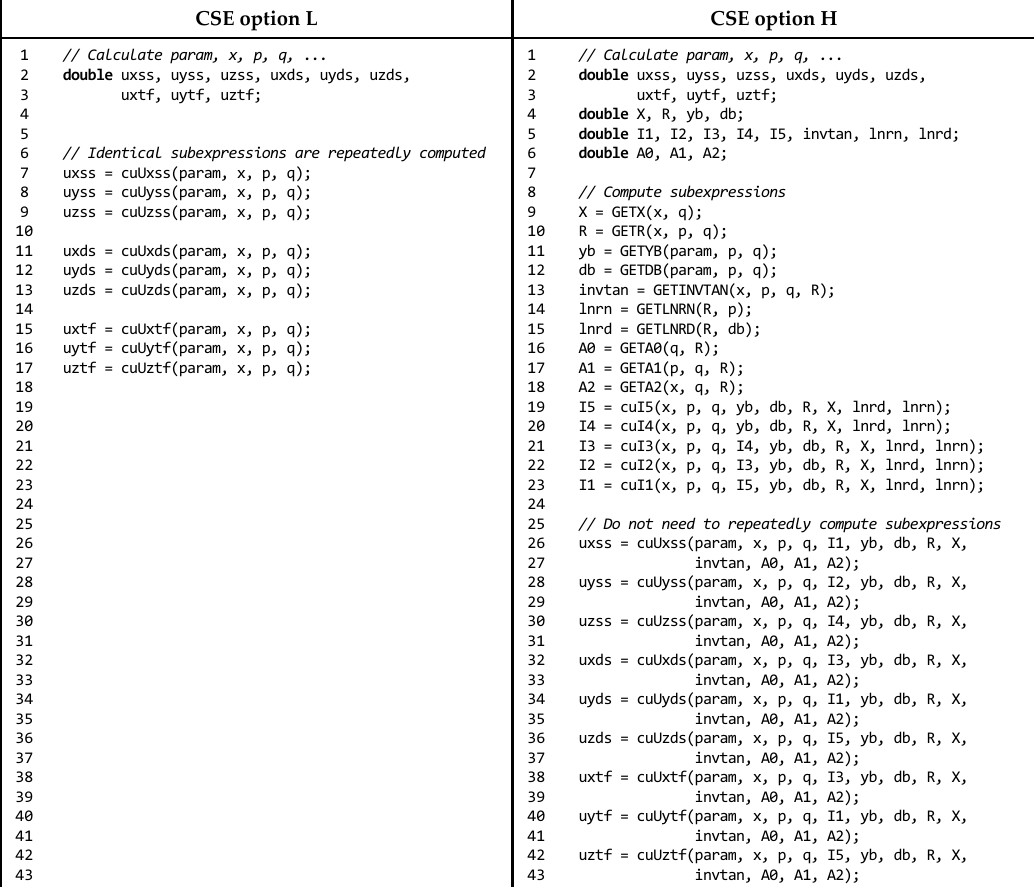
Figure 6. Comparison of the L and H options for